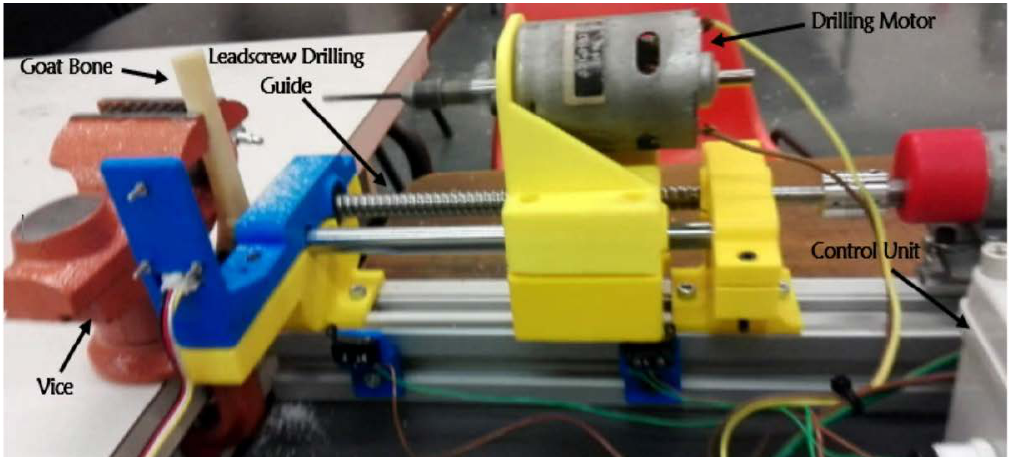
Figure 3: Smart automatic bone drill